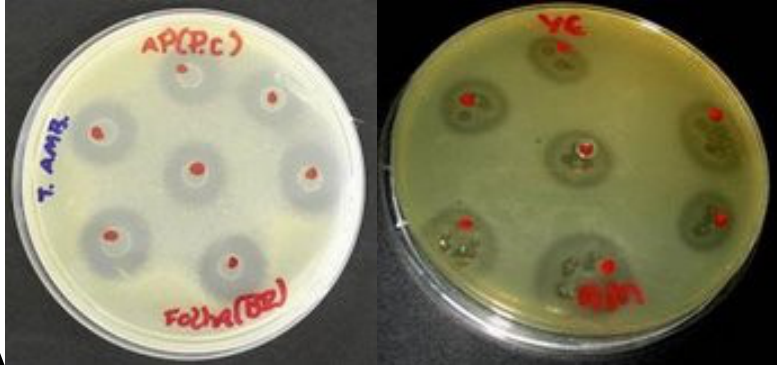
Figure 4. The isolated microorganism from Prunus spp. leaves (yellowish colony) showed inhibition halos against Staphylococcus coagulase-positive strain in peptone agar (A) and yeast extract agar